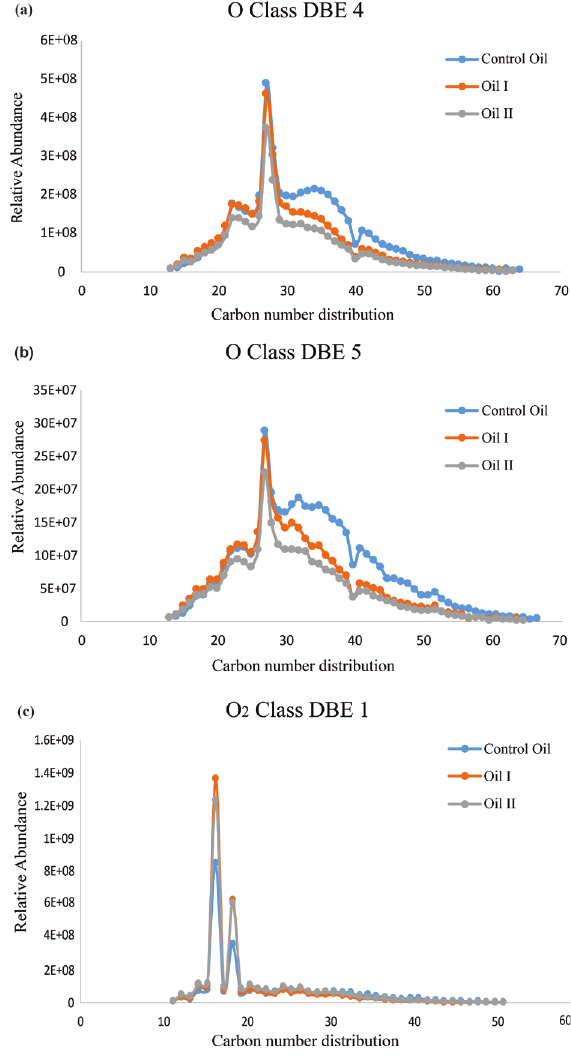
Figure 8. Carbon number distributions of the (a) O